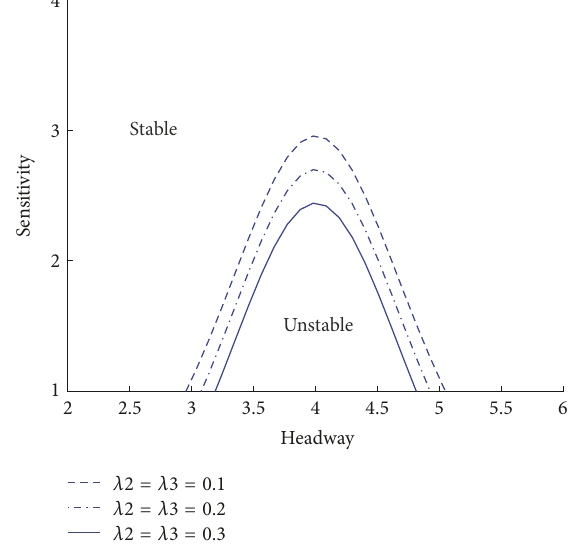
Figure 3: Different stable curves with different 𝜆 2 and 𝜆 3 in LVRD model.